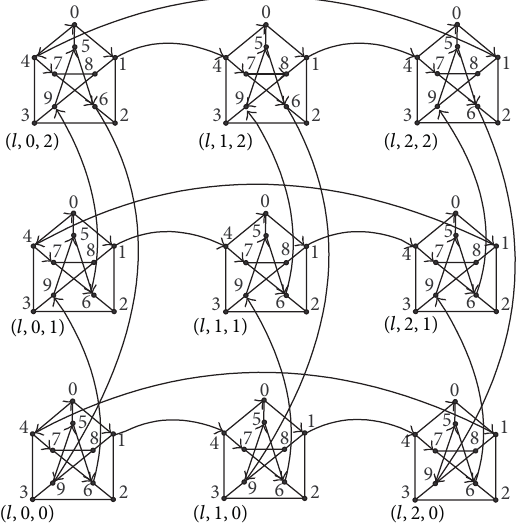
Figure 3: Example of Steps 2 and 3 of the all-to-all broadcasting in 3 PT (𝑙,3, 3) under SLA model.